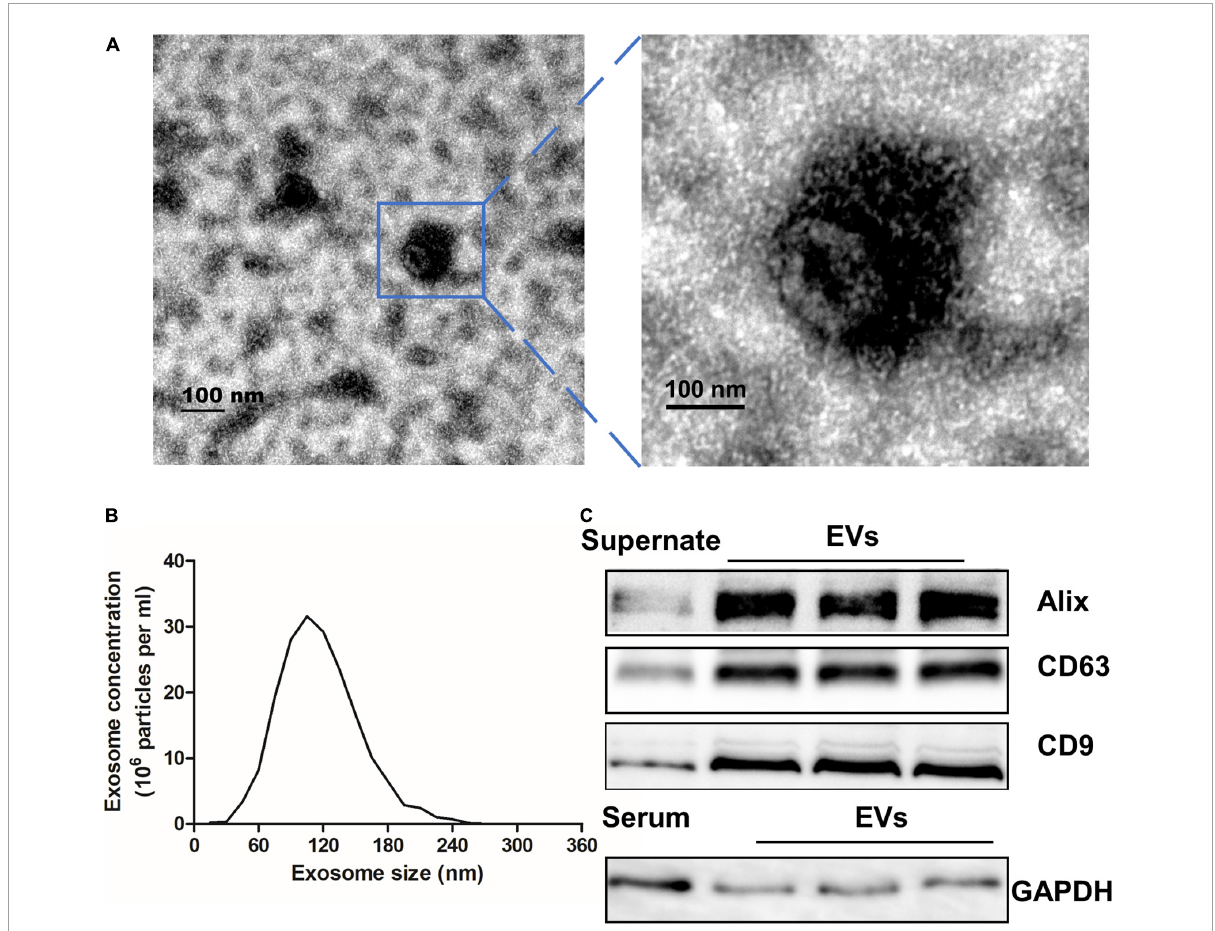
FIGURE1 Characterization of EVs extracted from serum. (A) Transmission electron microscope was used to analyze extracted exosomes which were zoomed indicated by the blue frame. Scale bar = 100 nm. (B) The particle size of serum EVs was measured with a Nanoparticle Tracking Analysis. (C) EVs and Supernate or serum were detected by Western blot for the exosome-riched markers Alix, CD63, and CD9, and the negative marker GAPDH. EVs, extracellular vesicles; GAPDH, glyceraldehyde-3-phosphate